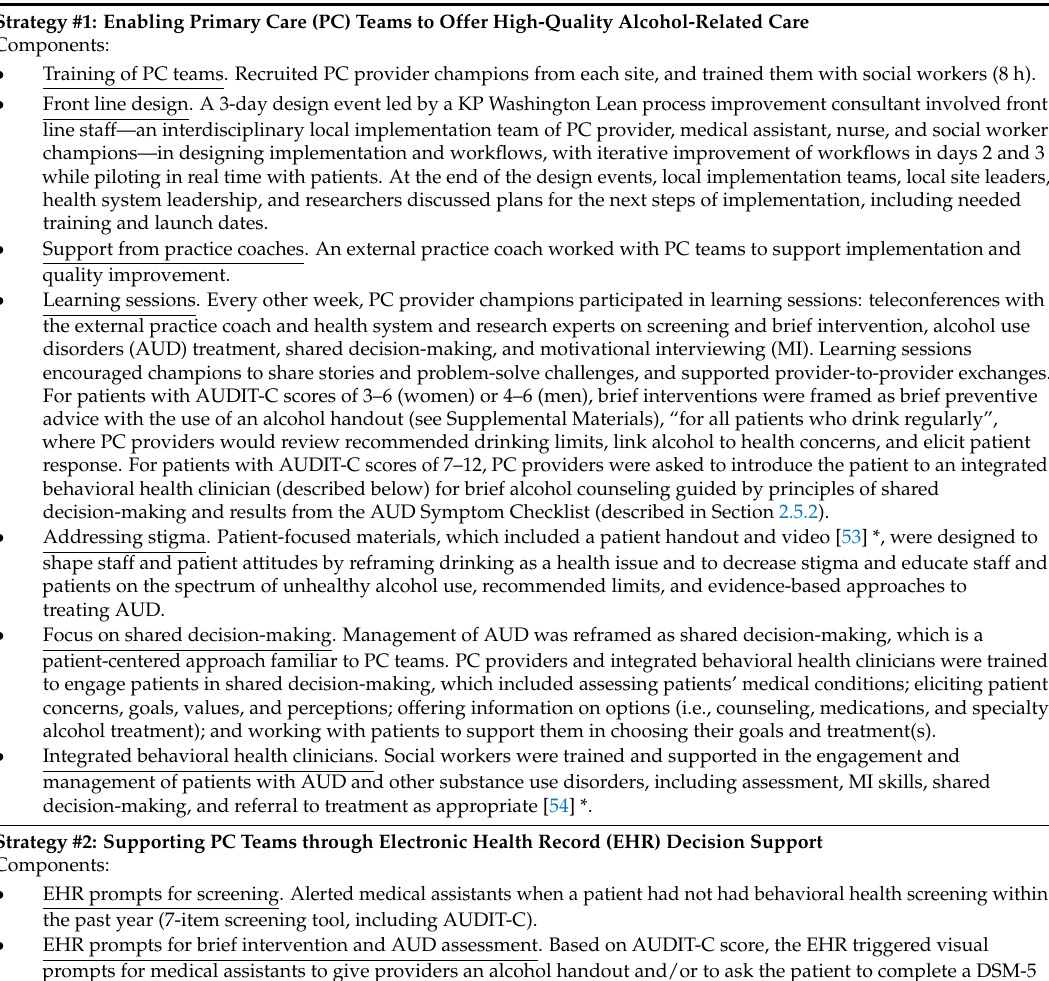
Table 1. The Program of Sustained Patient-centered Alcohol-related Care (SPARC): Components of the Implementation